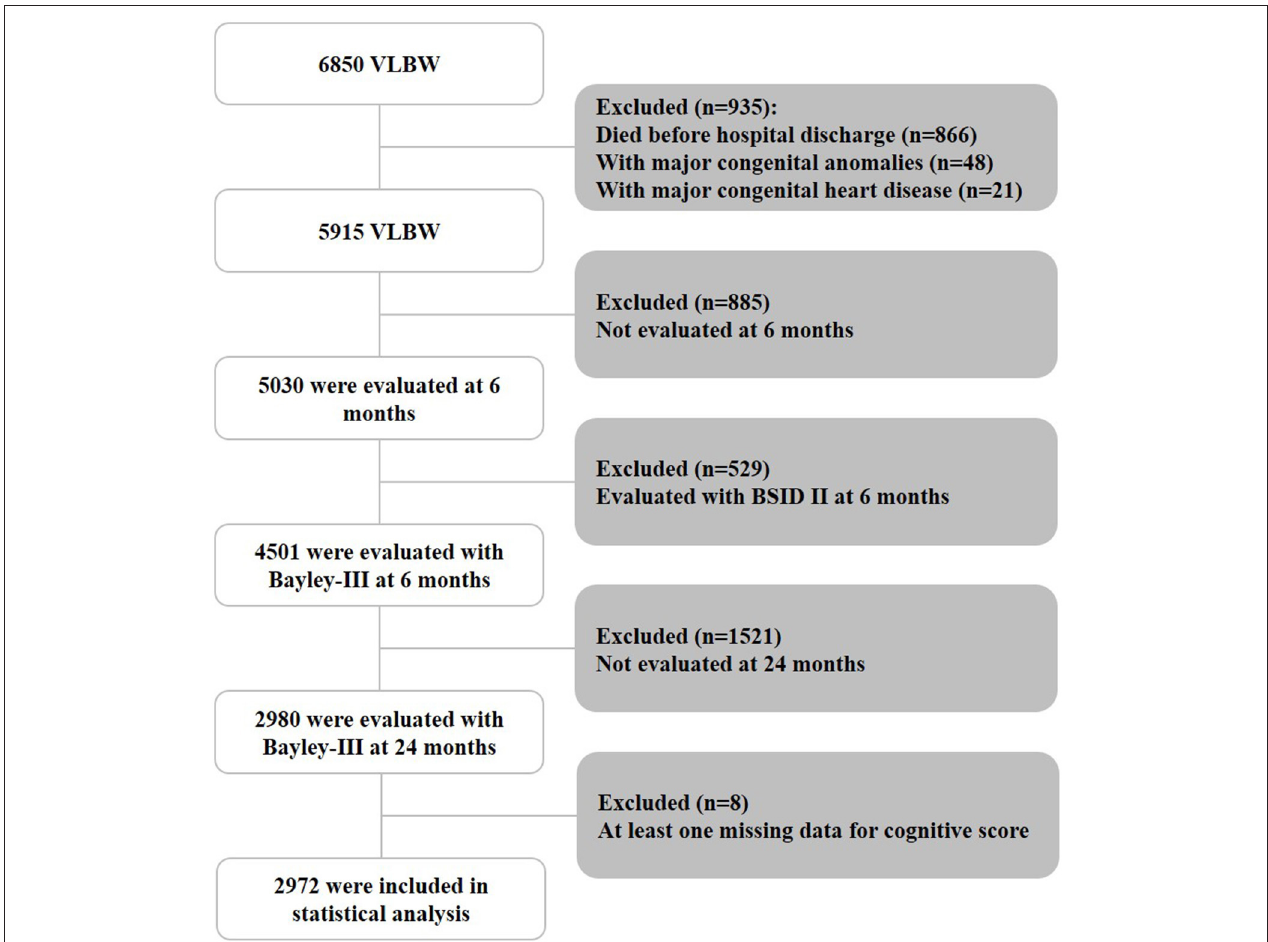
FIGURE 1 | Patient inclusion flowchart. BSID II, Bayley Scales of Infant Development, Second Edition; VLBW, very low birth weight.